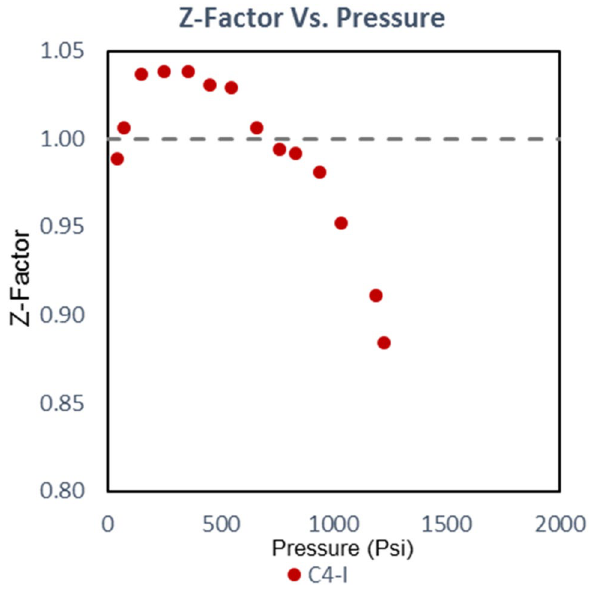
Fig. 14 Invalid trend of gas compressibility factor—DL